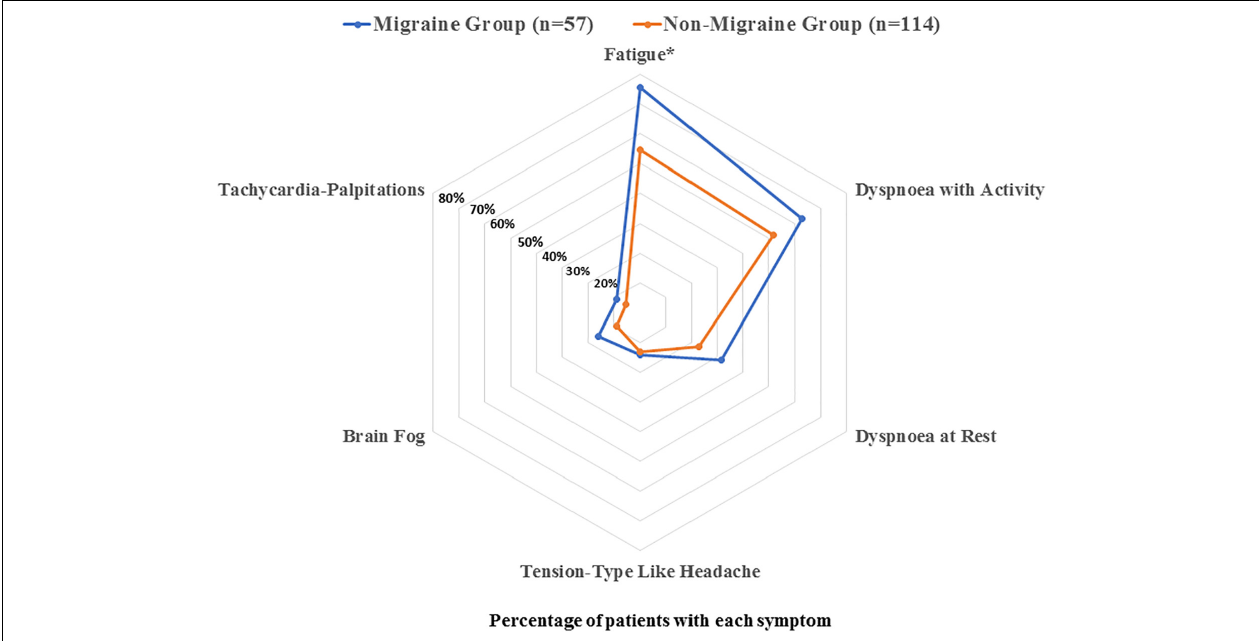
FIGURE 1 | Distribution of the most prevalent post-COVID symptoms (fatigue, dyspnoea with activity, dyspnoea at rest, tension-type like headache, brain fog, and tachycardia) in coronavirus disease 2019 (COVID-19) patients with and without previous migraine